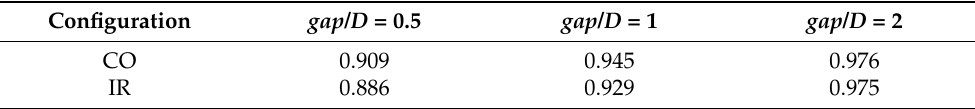
Table 2. Simple average of normalized powers under assumption of isotropic 16-directional wind